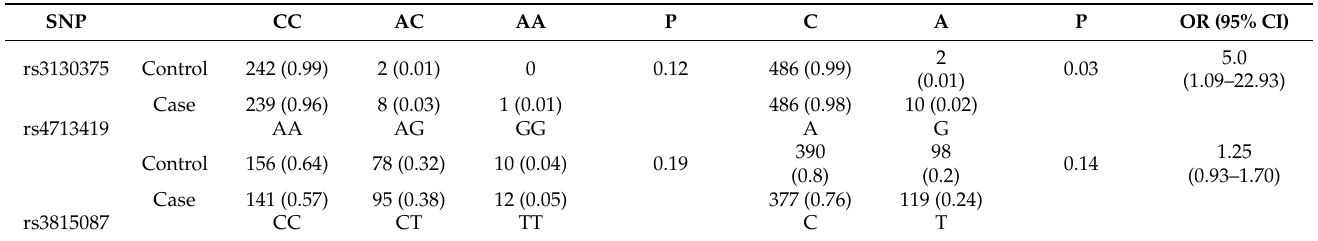
Table 2. Genotype and allele frequencies of the SNPs in MHC region with